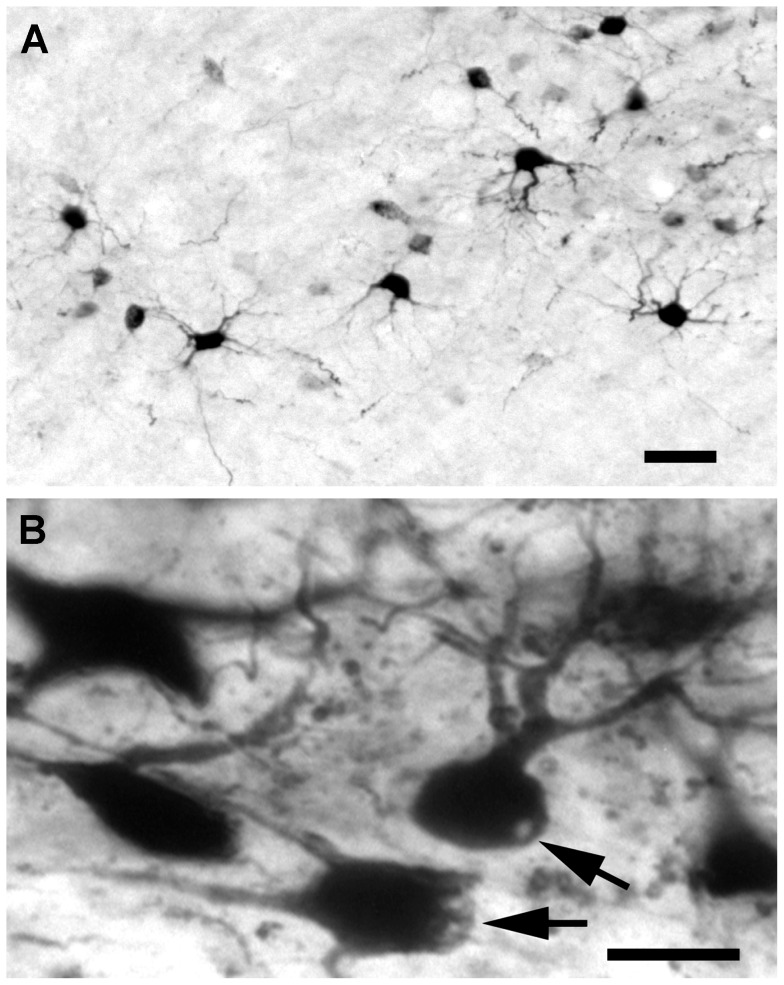
Response to axotomy from a lesion of the visual cortex at 7 days.(A) The majority of these neurons have multiple primary dendrites, few short secondary dendrites, and appear to be degenerated radial cells. (B) The cell somas of many dLGN projection neurons appear to contain vacuoles (upper arrow) and also display membrane blebbing (lower arrow). Scale bar: 50 µm (A) and 20 µm (B).